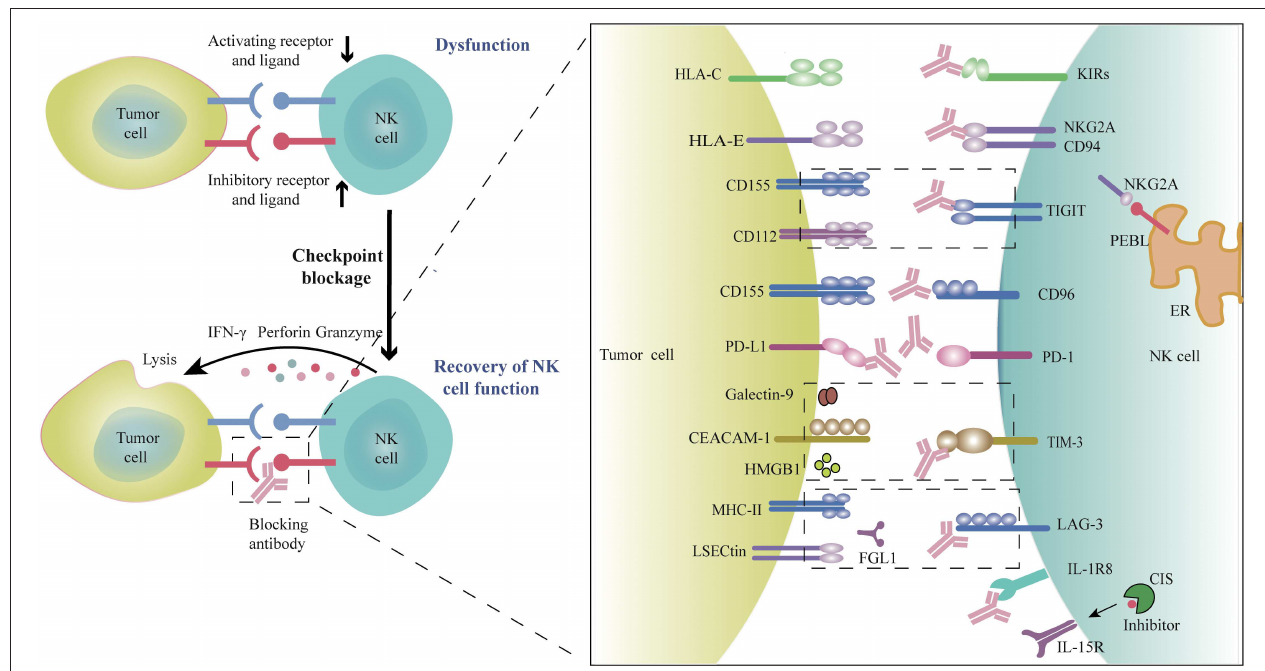
FIGURE 1 | Blockade of checkpoint inhibitors or molecules promotes NK cell anti-tumor efficacy. Many factors in the tumor microenvironment induce NK cell dysfunction, as evidenced by the upregulation of inhibitory checkpoint receptors and the downregulation of activating receptors on tumor-infiltrating NK cells, which can result in NK cell exhaustion. Blocking these immune checkpoint receptors or molecules using monoclonal antibodies would restore the anti-tumor activity of NK cells. Rationally, co-combination with different checkpoint inhibitors or combinations of checkpoint inhibitors with other therapeutic agents could further amplify anti-tumor